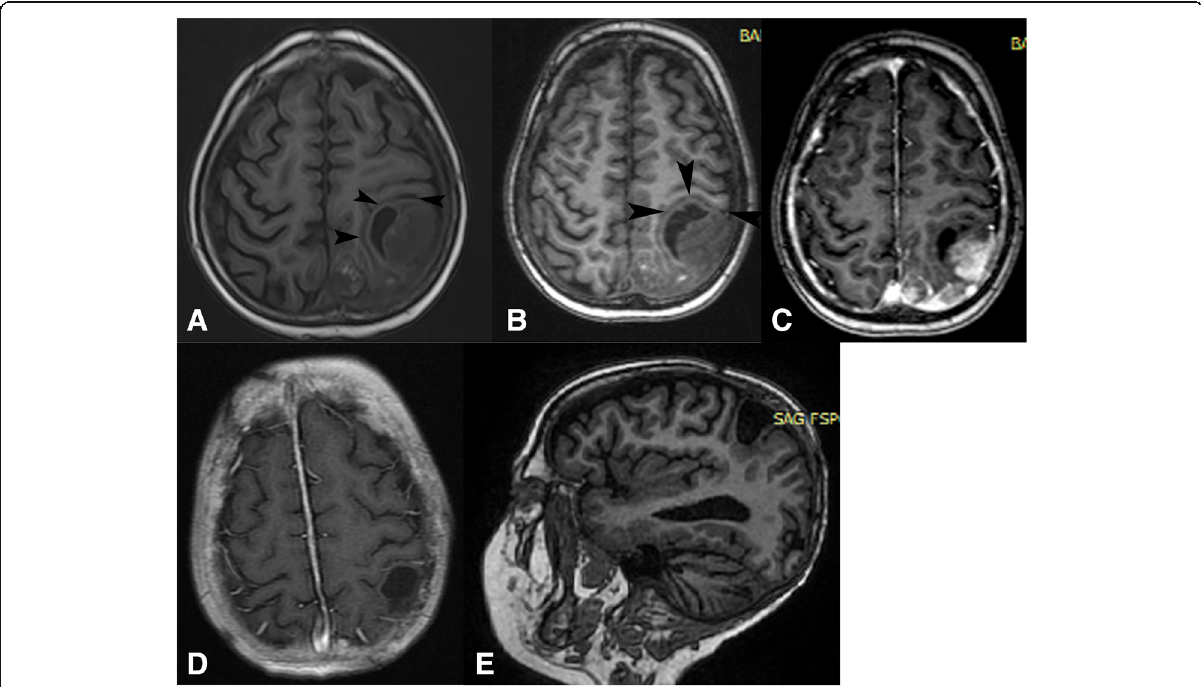
Fig. 1 a and b axial non-contrast T1WI. The arrowheads point to the sulcal approach. c represents axial post-contrast MRI. d and e are 18-month post-operative axial and sagittal MRI showing healthy gyral banks